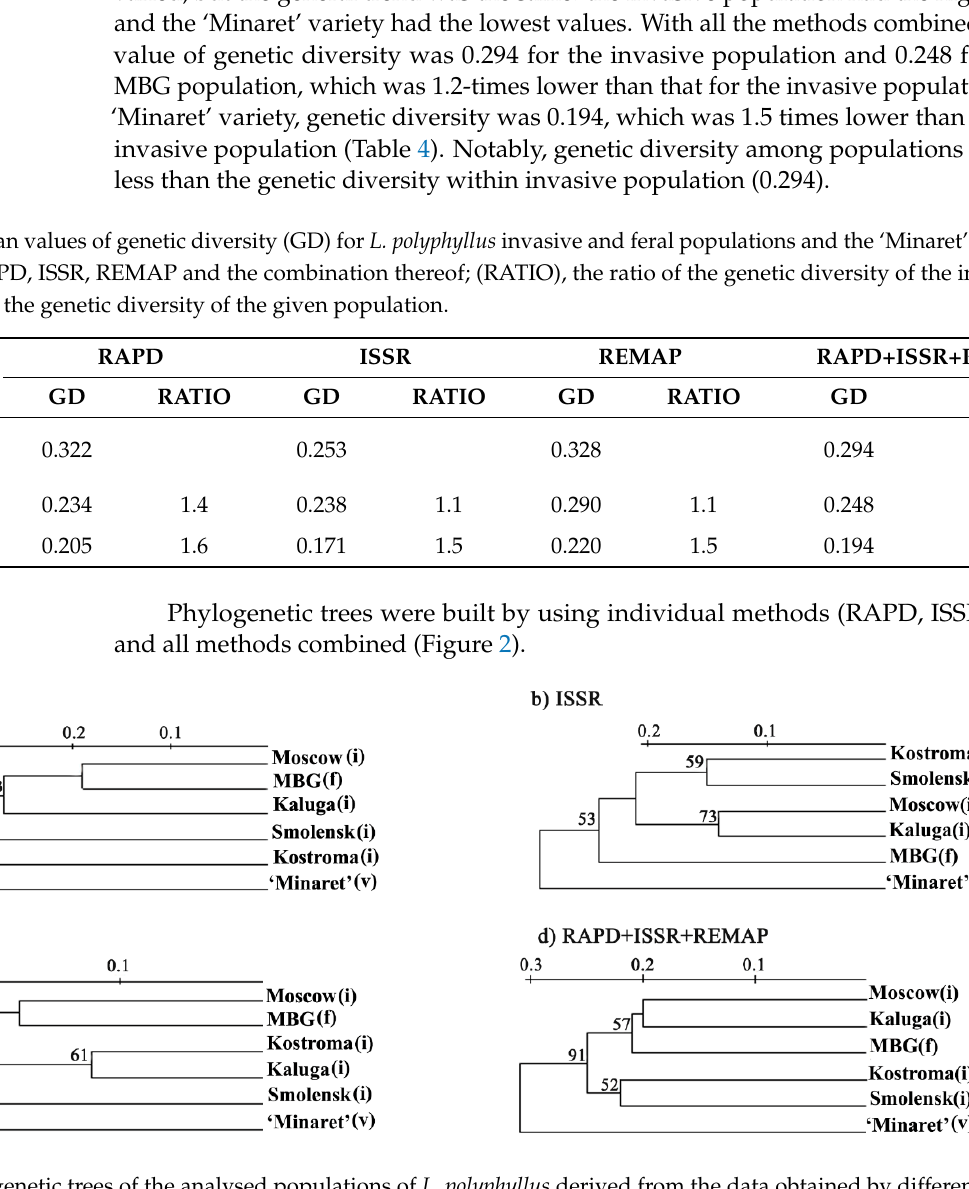
Figure 2. Phylogenetic trees of the analysed populations of L. polyphyllus derived from the data obtained by different methods. ( a ) Phylogenetic tree derived from the RAPD data, ( b ) Phylogenetic tree derived from the ISSR data, ( c ) Phylogenetic tree derived from the REMAP data, ( d ) Phylogenetic tree derived from the combination of RAPD, ISSR and REMAP data. The bootstrap values are given in %, (i)—invasive population, (f)—feral population, (v)—variety.